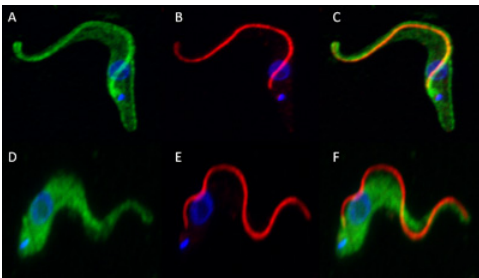
Fig 5. Confocal immunofluorescence microscopy showing localization of T . congolense calflagin in the presence and absence of calcium. Maximum intensity projections of fixed T . congolense PCF were probed with mAb Tc6/42.6.4 and anti-para-flagellar rod protein in the presence (A, B, and C) and absence (D, E, and F) of calcium. Green: calflagin; Red: para-flagellar rod protein; Blue: DAPI/DNA.